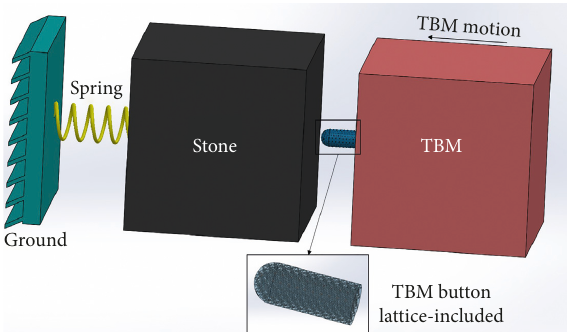
Figure 16: Schematic illustration of the modelling conditions of button impacting stone. The button and the stone are both modelled with